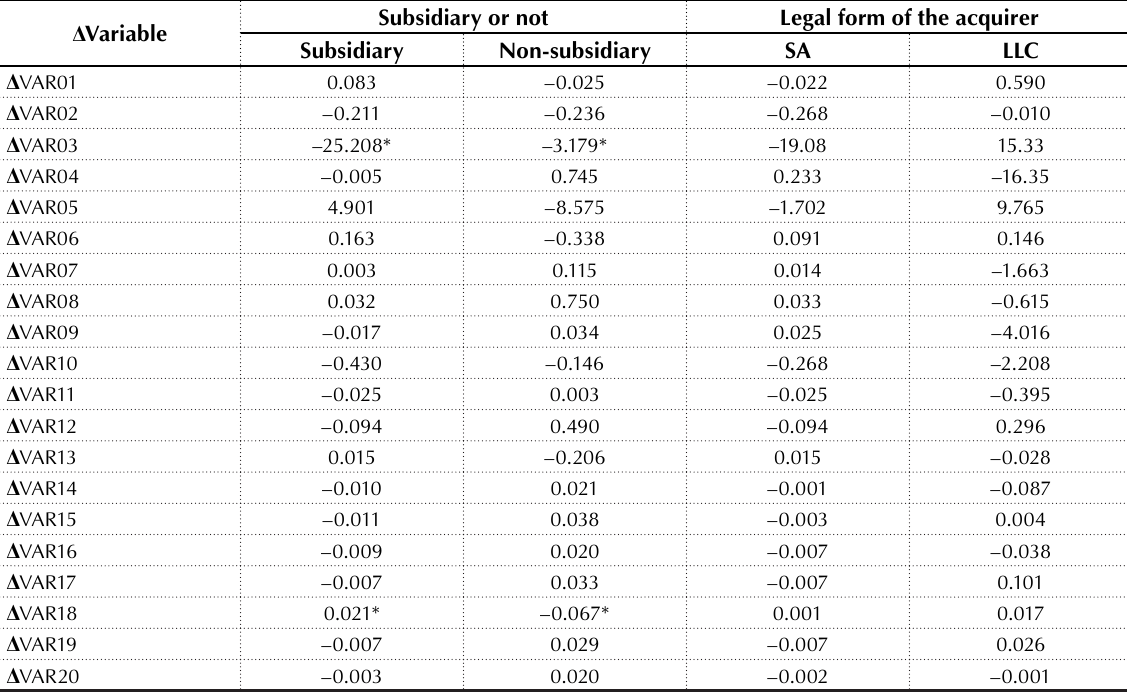
Table 7. Results (Kruskal-Wallis test) based on subsidiary or non-subsidiary and legal form of the acquirer ( H6 - H7